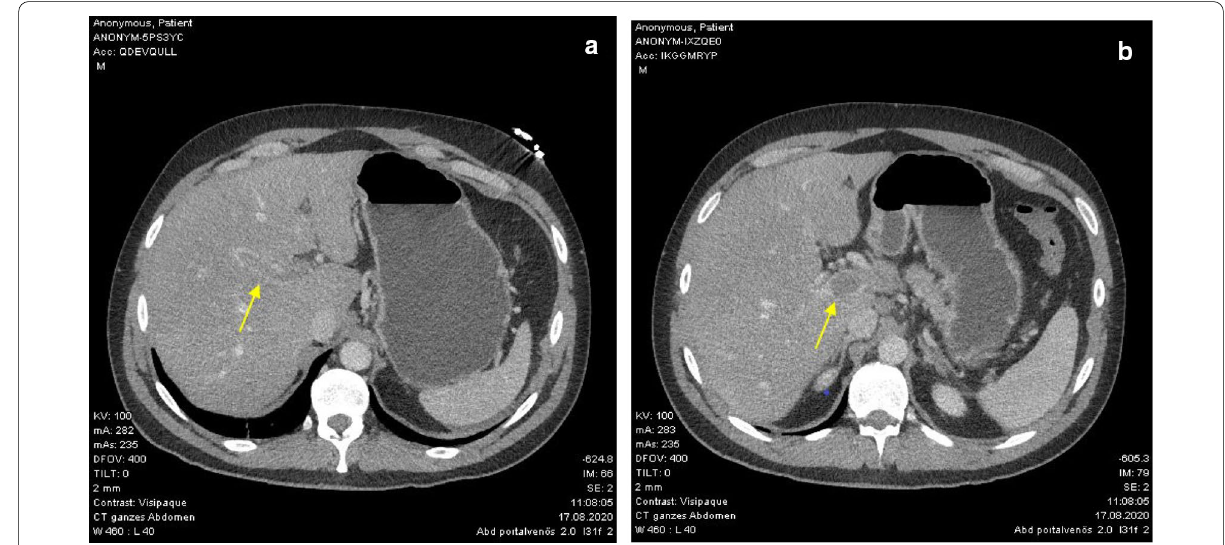
Fig. 1 a , b CT‑scan with portal vein thrombosis on admission, which occludes nearly the whole caliber (yellow